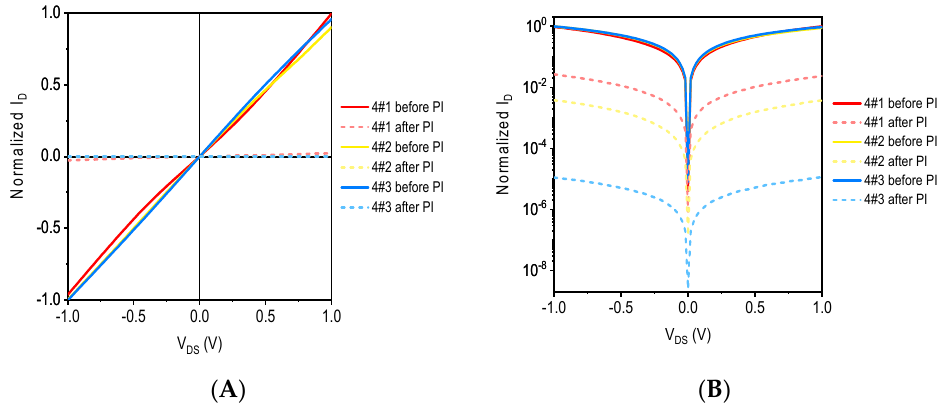
Figure 10. The output characteristic curve of graphene samples before and after proton irradiation. ( A ) Linear coordinates and ( B ) logarithmic coordinates.